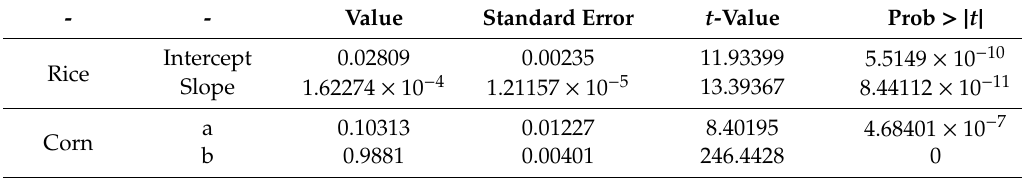
Table 7. Test results of the significance of the equations of the unit energy consumption regression model. - Sum of Squares Mean Square F-Value Prob > F Rice 0.00546 0.00546 Corn